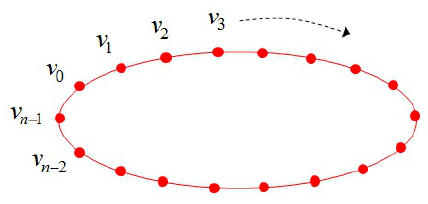
Figure 1. Snake curve initialised in the form of a parametric